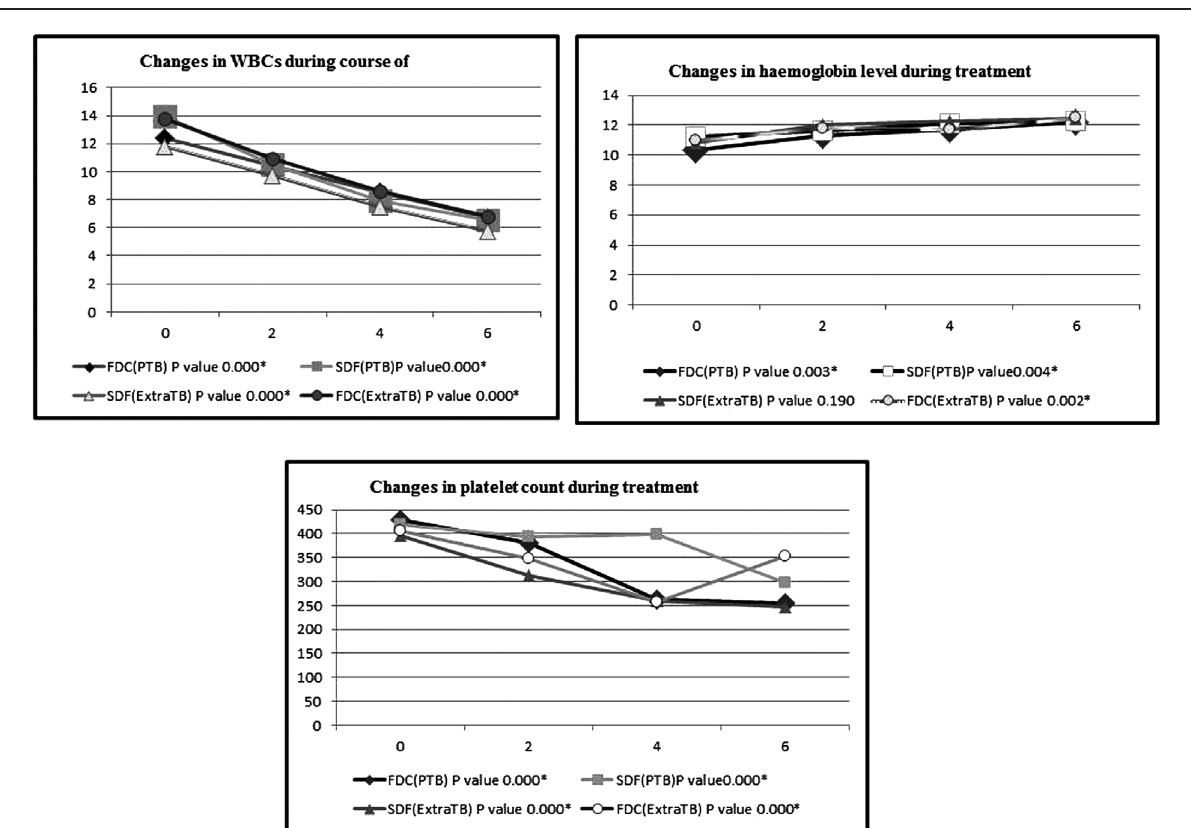
Changes in blood picture during course of